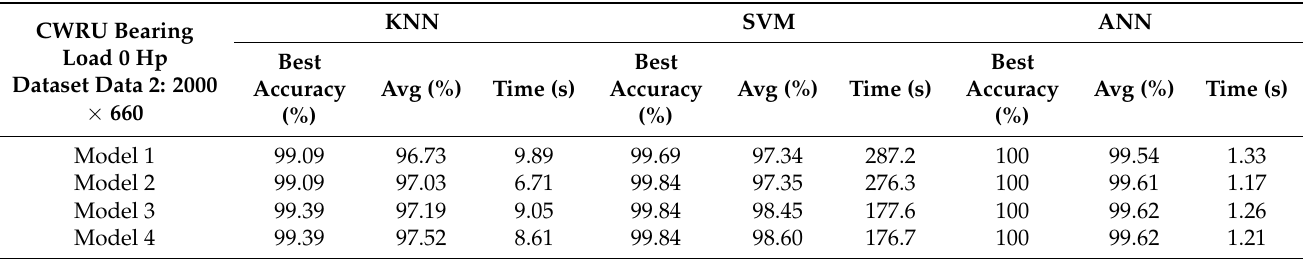
Table 6. Result in CWRU bearing load 0 Hp